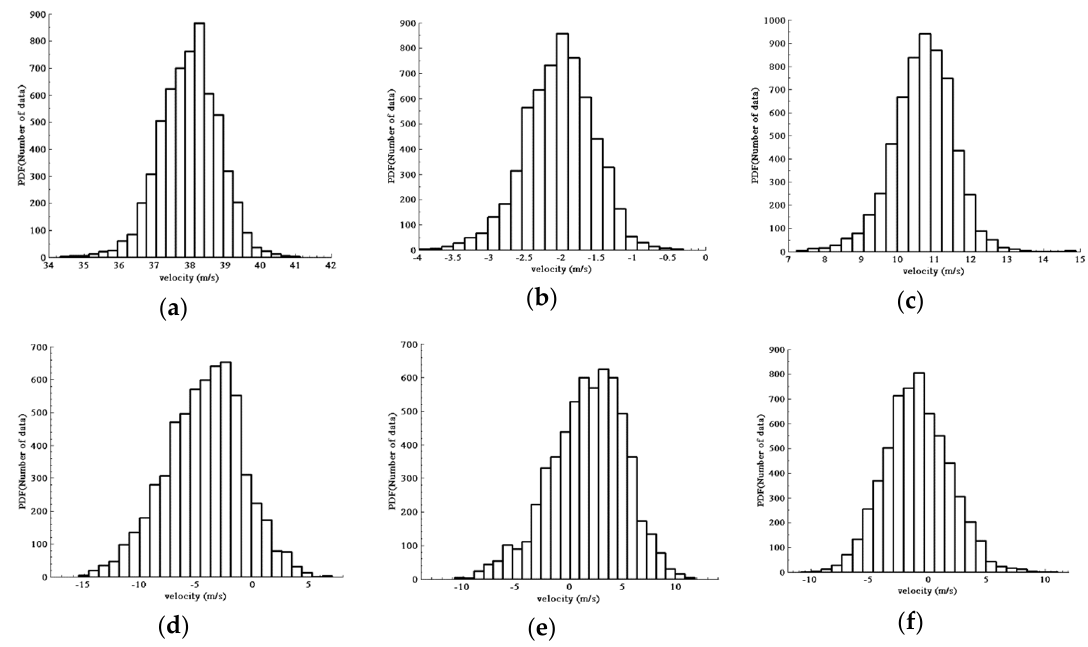
Figure 14. Velocity probability density function (PDF) distribution of monitor points in three directions at 20% span: ( a ) P1 streamwise; ( b ) P1 spanwise; ( c ) P1 pitchwise; ( d ) P2 streamwise; ( e ) P2 spanwise; ( f ) P2 pitchwise.